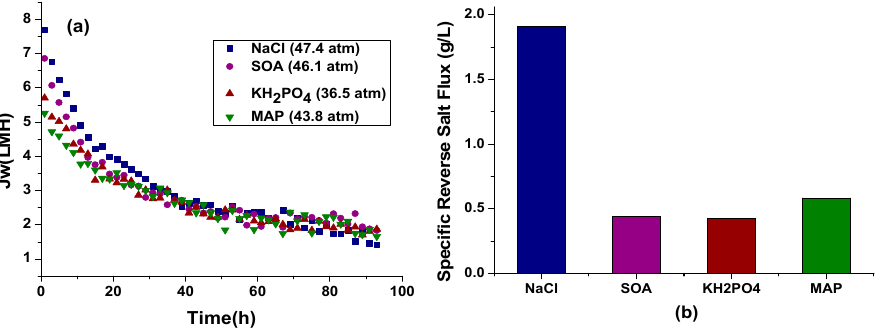
Figure 3. ( a ) Water flux of different fertilizer draw solutions in the MF ‐ FDFO ‐ MBR hybrid system; and ( b ) specific reverse salt flux of different fertilizer draw solutions in the MF ‐ FDFO ‐ MBR hybrid system (Feed solution: Synthetic wastewater; DS concentration: 1 M; Flow rate: 200 mL/min, Temperature: 22 ± 0.5 ◦